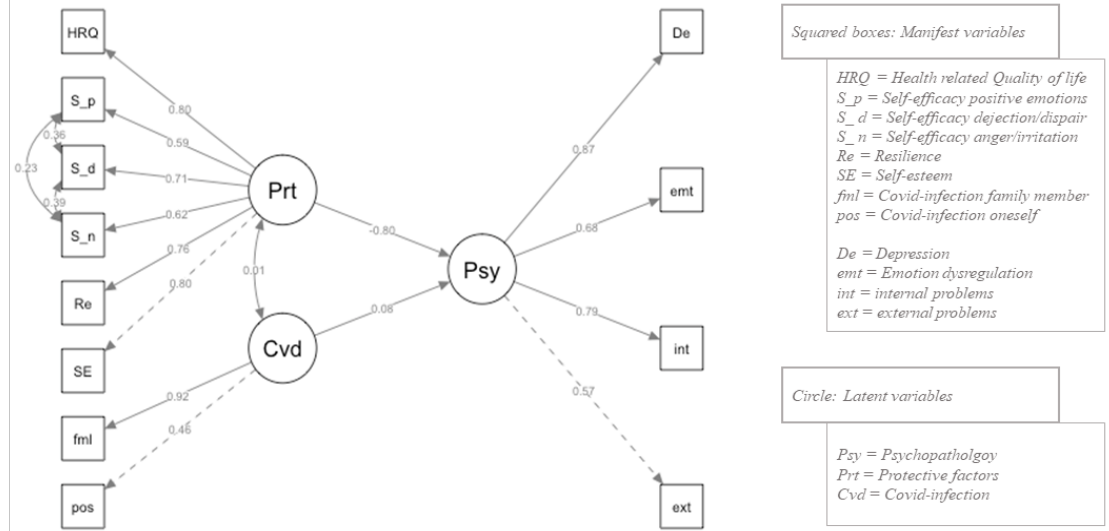
Figure 3. Final SEM path model.